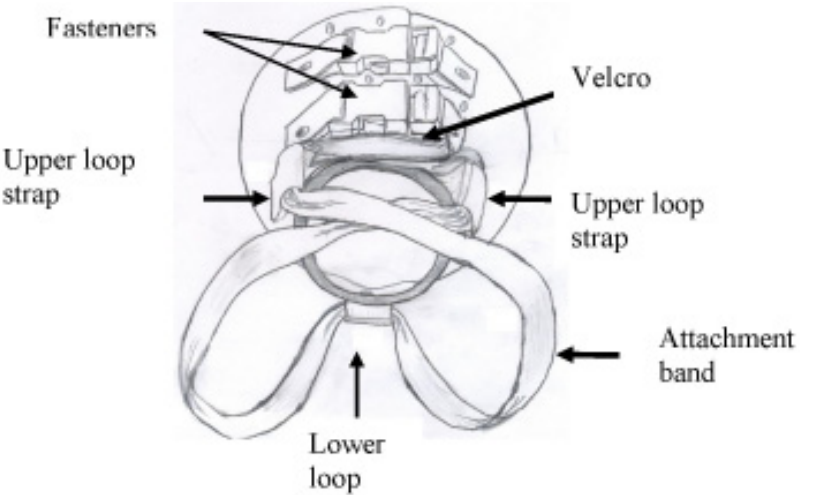
FIGURE 6 - Drawing of the posterior view of the cervical isolation collar for rabbits, closed with the back fasteners (see indication), showing how the attachment band passes through the upper and lower loop straps, as indicated, and how the free ends are joined together at the back of the neck with